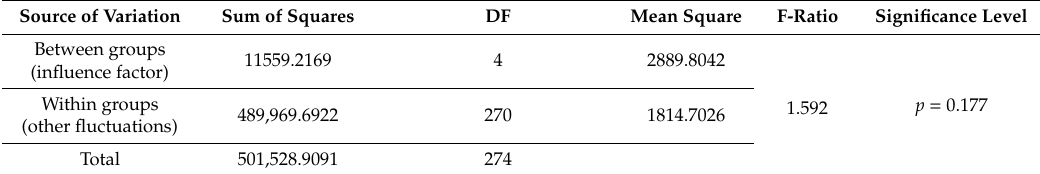
Table 5. Group di ff erences in leisure-time exercise